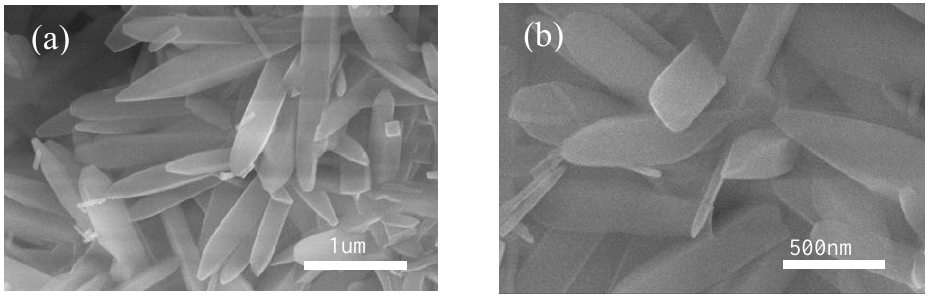
Figure 14. Magnified SEM images of mullite whiskers (5% AlF 3 , 3H 2 O, 825°C, 5 h). ( a ) for magnifi- cation 100,000×; ( b ) for localized mullite whiskers with magnification 200,000×.